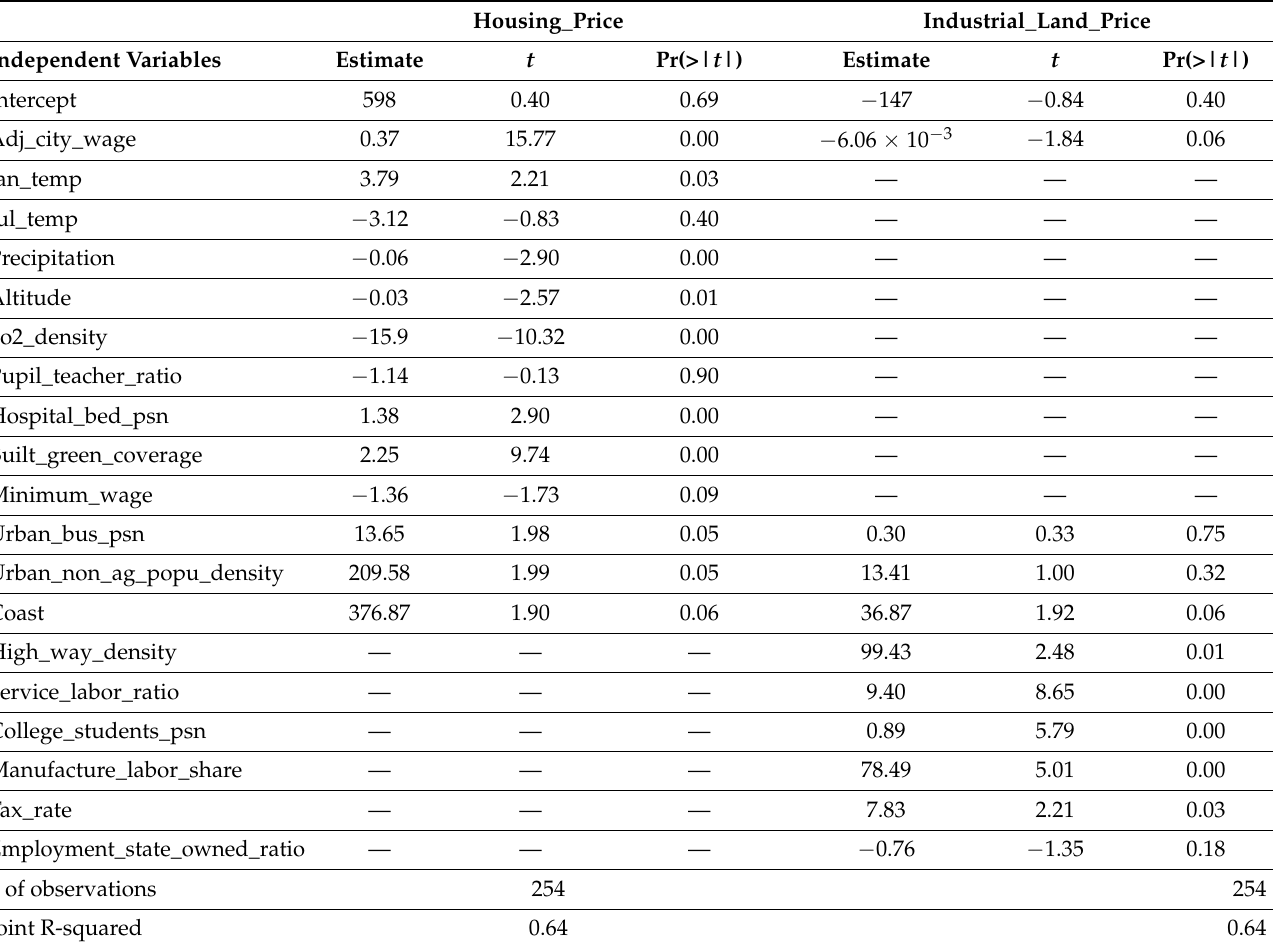
Table 2. Regression estimates of housing and land prices.